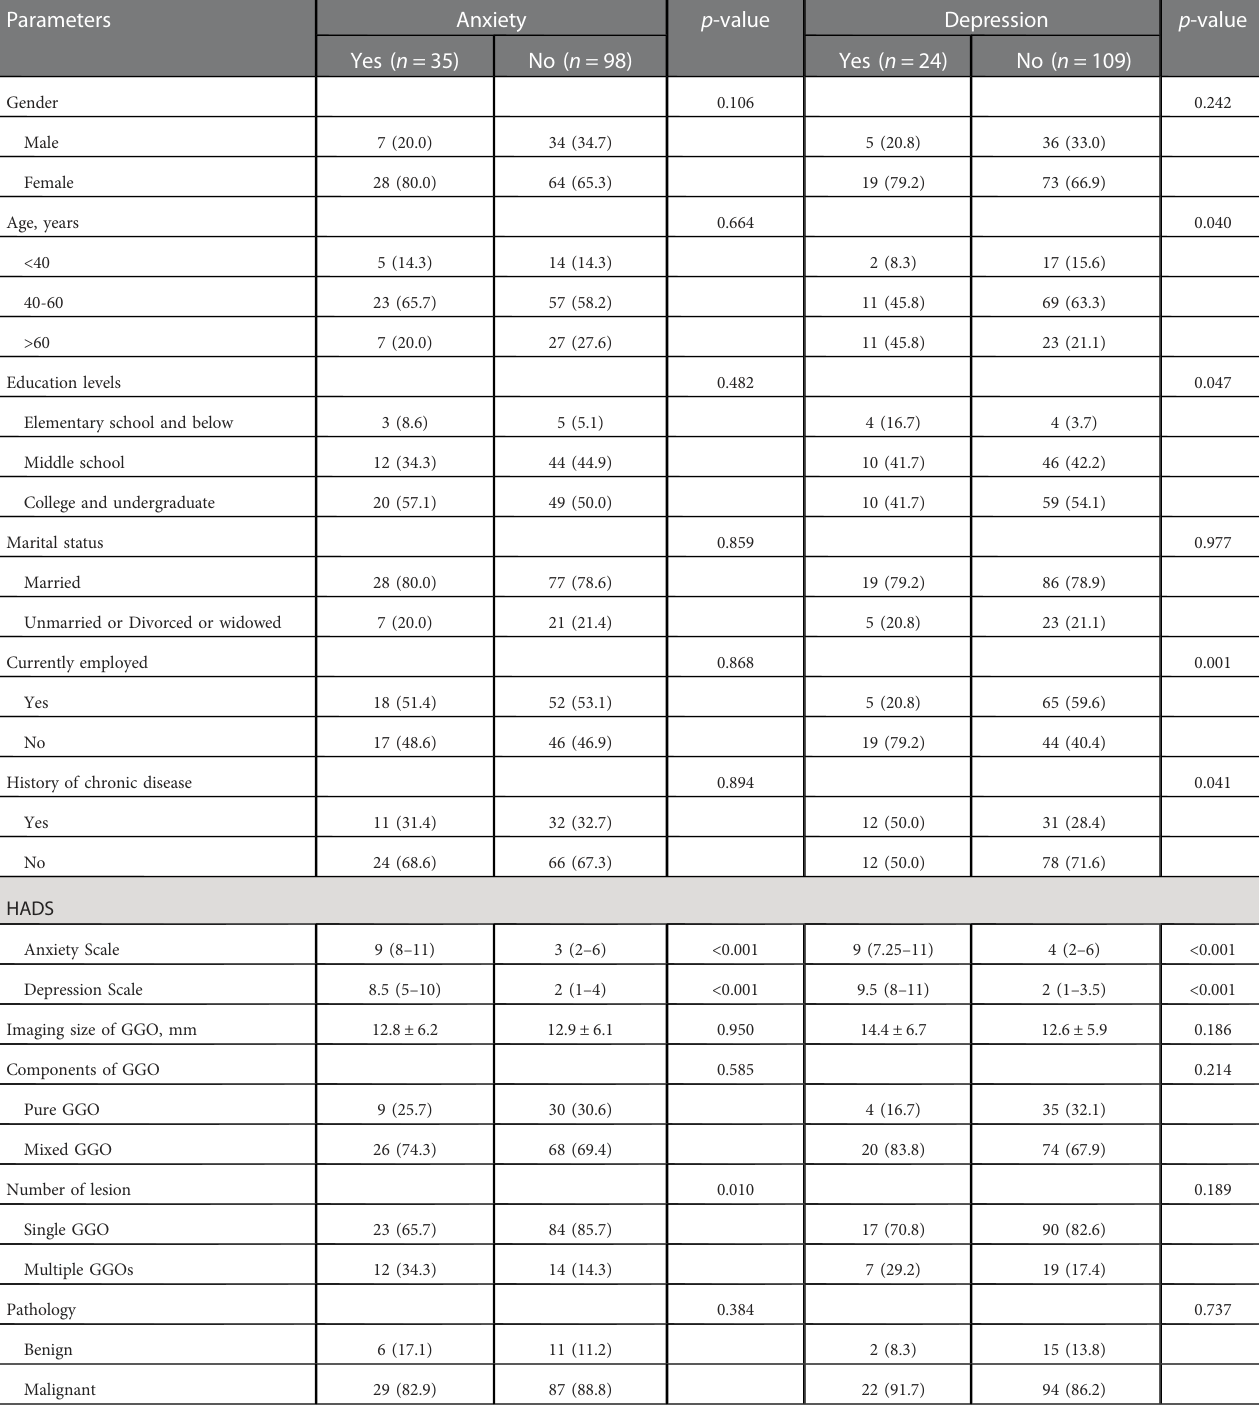
TABLE 2 Analysis of risk factors of anxiety and depression for patients with pulmonary